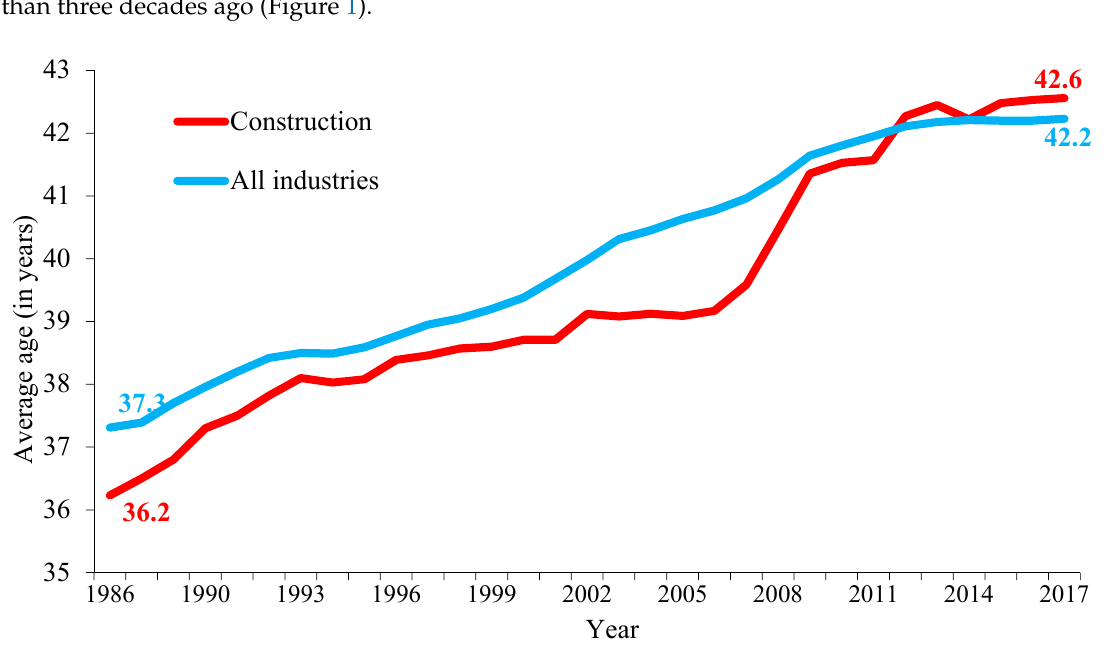
Table 1. Average age of construction workers by occupation, U.S. born versus immigrant worker, average of 2015–2017 (All employment).